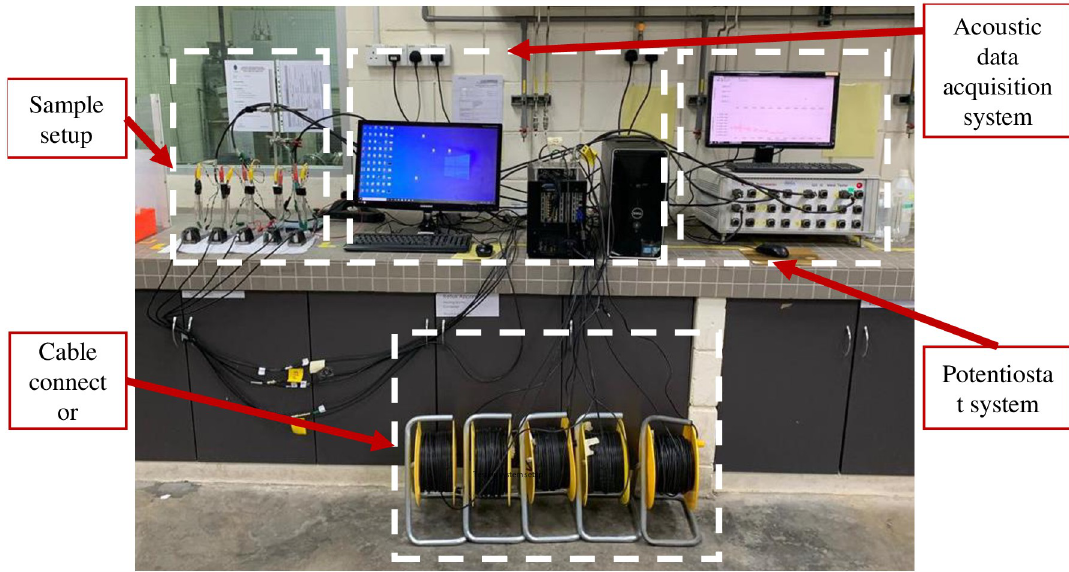
Fig 2. Carbon-steel LPR test experimental